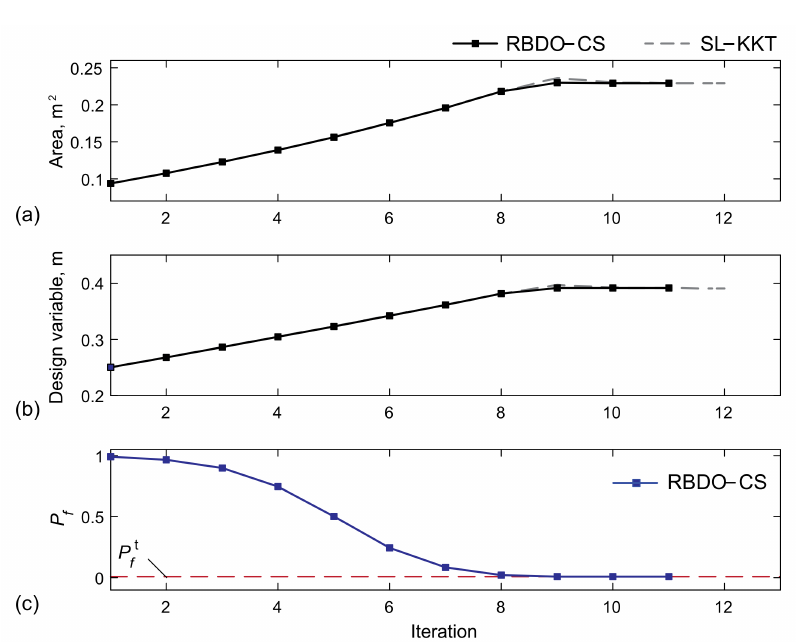
Figure 4. Convergence history of the proposed RBDO − CS and SL − KKT approaches: ( a ) optimal area; ( b ) design variable; and ( c ) failure